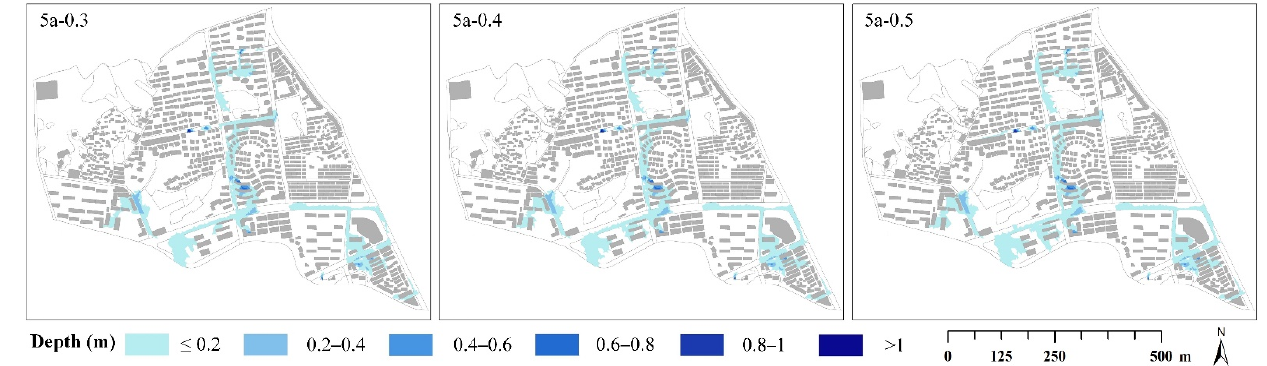
Figure 6. The inundation scene with different rainfall peak position coefficients ( t = 120 min and P = 5a).